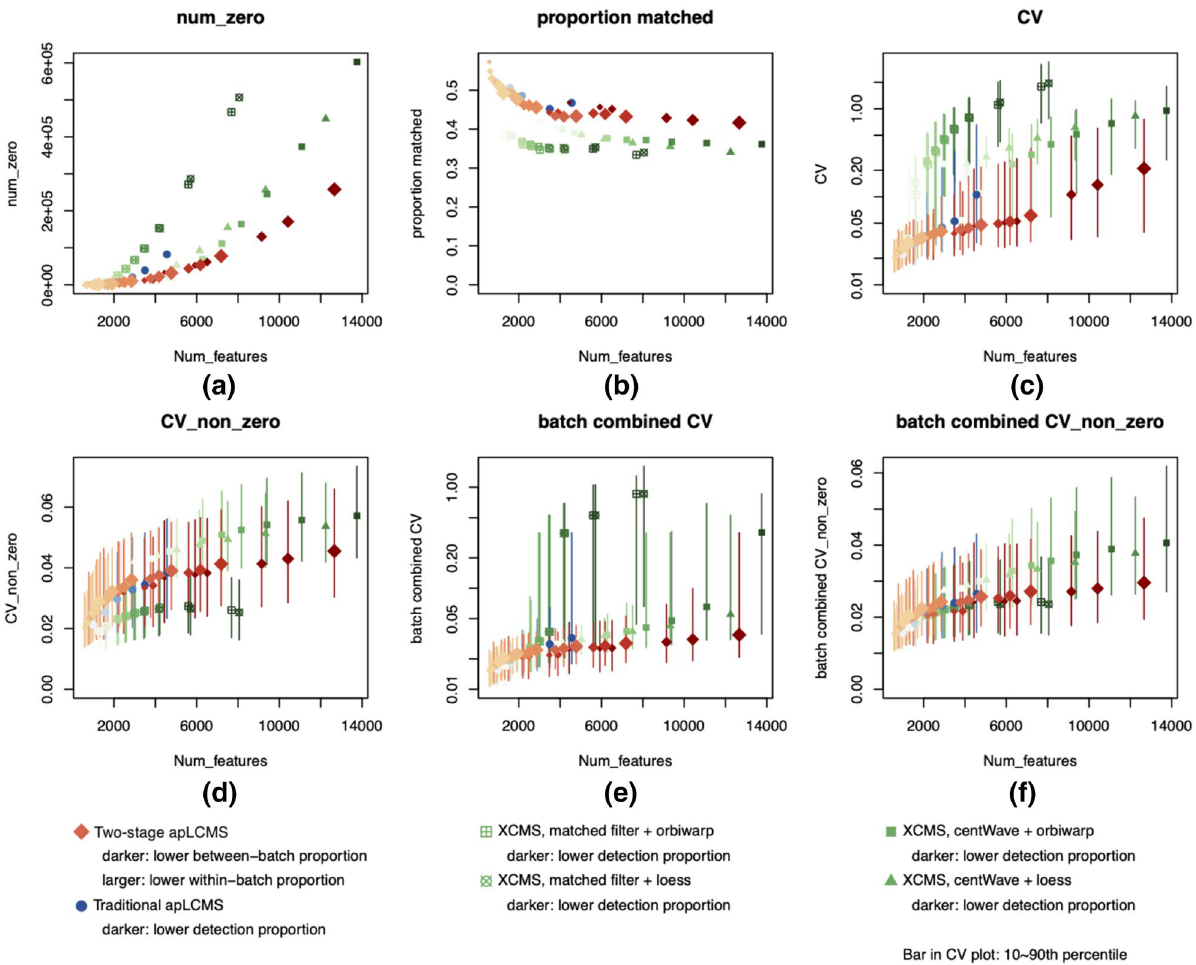
Figure 2. Comparison of the two-stage preprocessing approach with traditional apLCMS and XCMS using standard sample. Each dot represents a parameter setting. ( a ) Total number of zeros in the final data matrix; ( b ) proportion of features with m/z matched to known metabolites using xMSAnnotator; ( c ) level of variation as measured by coefficient of variation (CV) in the final data matrix without considering batches; (d) level of variation as measured by coefficient of variation (CV) in the final data matrix without considering batches, considering only non-zero values; (e) level of variation as measured by CV after merging each batch; (f) level of variation as measured by CV after merging each batch, considering only non-zero values. In all CV plots, the point is median; vertical bars represent 10th to 90th